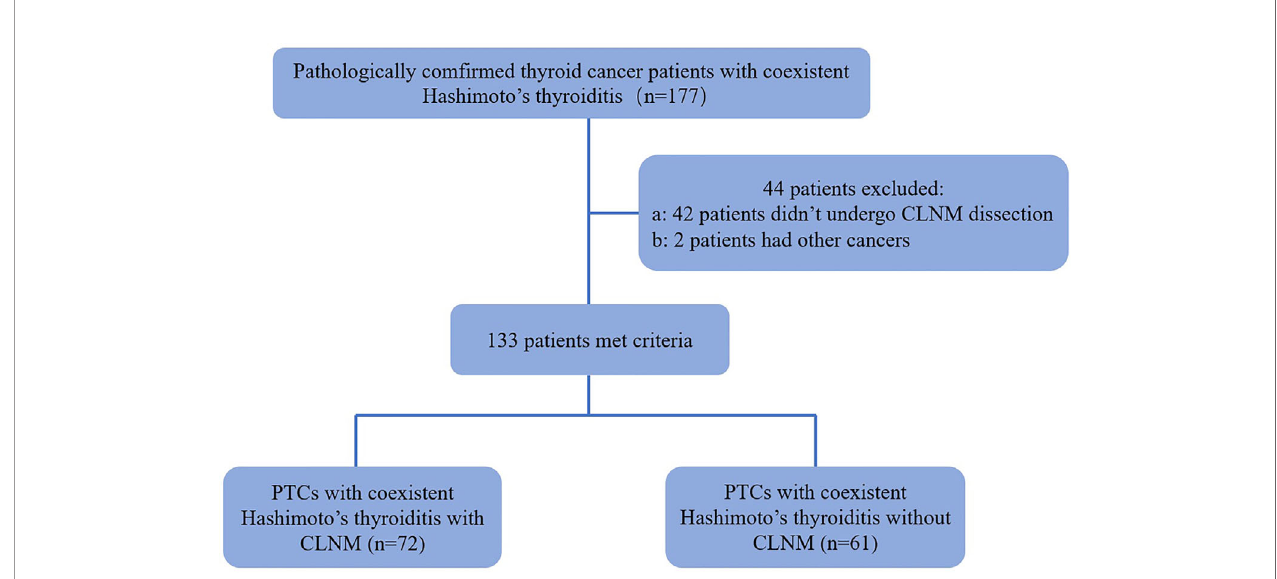
FIGURE 1 | Flowchart for the selection of thyroid cancer patients. PTC, papillary thyroid carcinoma; CLNM, Central Lymph Node Metastasis.